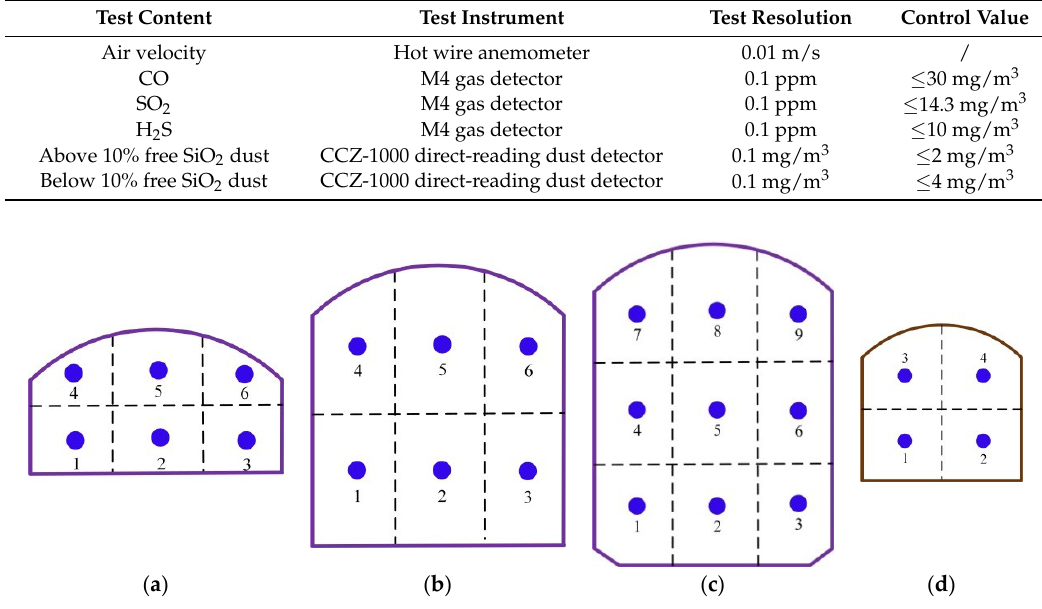
Figure 3. Layout of test points in each section: ( a ) Section of the upper layer; ( b ) Section of the middle layer; ( c ) Full section of the cavern; ( d ) Construction roadway.